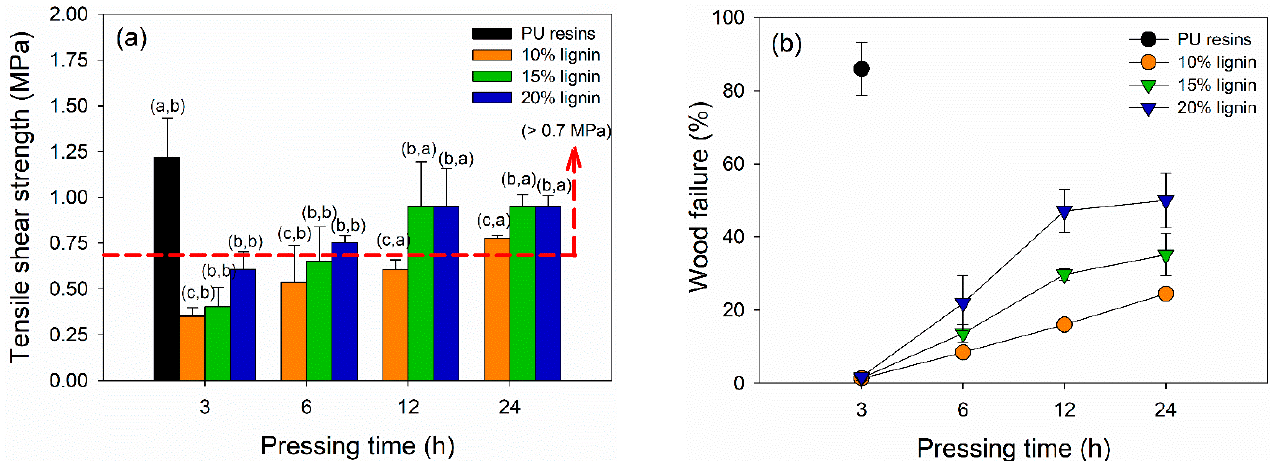
Figure 7. Influence of different lignin contents on the shear strength of plywood at different pressing times: ( a ) tensile shear strength (TSS), ( b ) wood failure. Table 6. Statistical analysis of mechanical properties of plywood bonded with PVOH–lignin–hexamine-based adhesives at different lignin contents and pressing times.